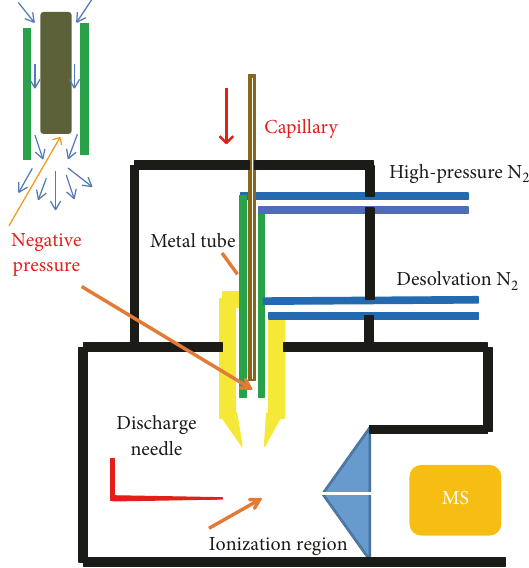
Figure 1: Schematic diagram of modified APCI